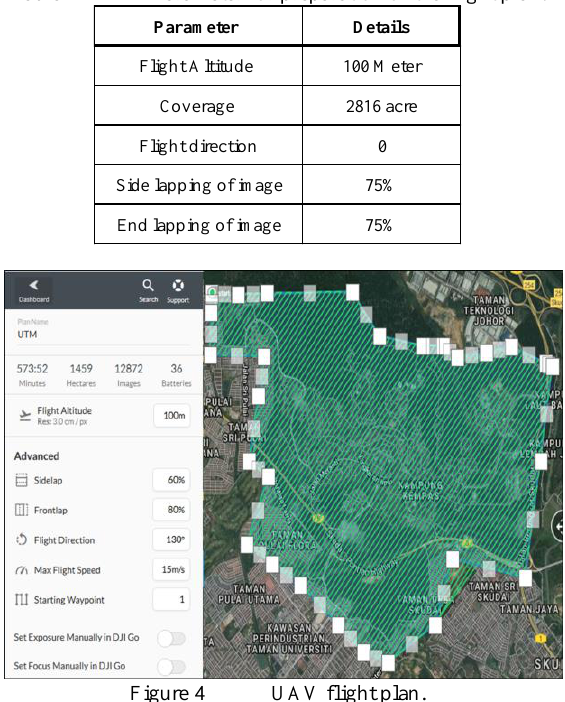
Parameter for preparation of the flight plan.